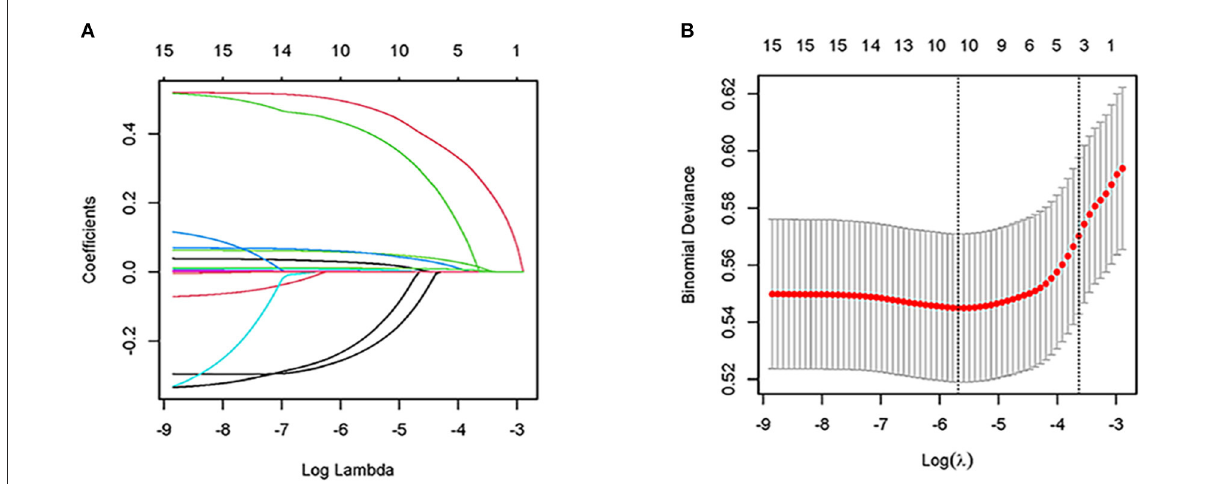
FIGURE2 Clinical feature selection by LASSO. (A) Plot of LASSO coefficient profiles of the 20 features. The log (lambda) sequence was plotted against a coefficient profile plot. There were 10 features with non-zero coefficients generated by the ideal lambda ( λ = 0.003403811); (B) 10-fold cross-validation for LASSO model parameter adjustment. The binomial deviation curve was displayed with log (lambda). The minimum criteria and its one standard error were used to construct dotted vertical lines at the optimal values (the 1-SE criteria).